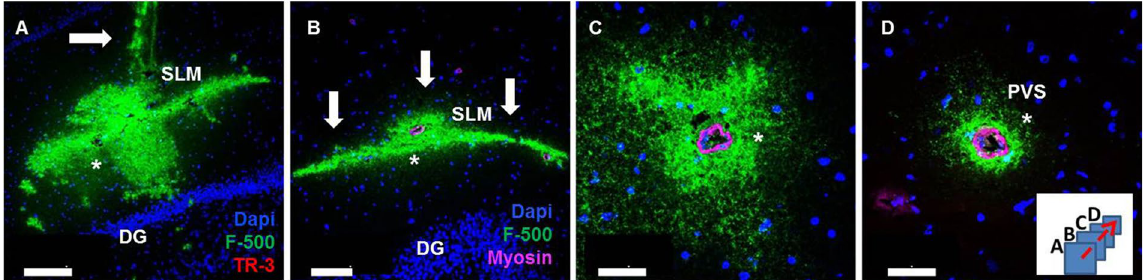
Figure 4. Tracer spreading within the hippocampus. Sequential sections of a SHR from the injection site (panel A; arrow indicates needle track) moving towards the caudal side of the brain (panels B–D). Tracer (500 kD) is shown in green. Panel B: 0.75 mm caudal from infusion area. Tracer spread along the SLM (arrows) and embedded arteries. Panel C: 1 mm from the infusion area, tracer co-localized with an artery. Panel D: 1.25 mm from the infusion area, stronger co-localization with the same artery. Dentate gyrus (DG); Stratum Lacunosum Molecolare (SLM); Paravascular Space (PVS). Stars indicate the same artery in the different panels. Blue: nuclear stain, magenta: smooth muscle myosin heavy chain, identifying the arterial nature of these vessels. Scale bar in A = 200 μ m, B = 100 μ m, C–D = 50 μ